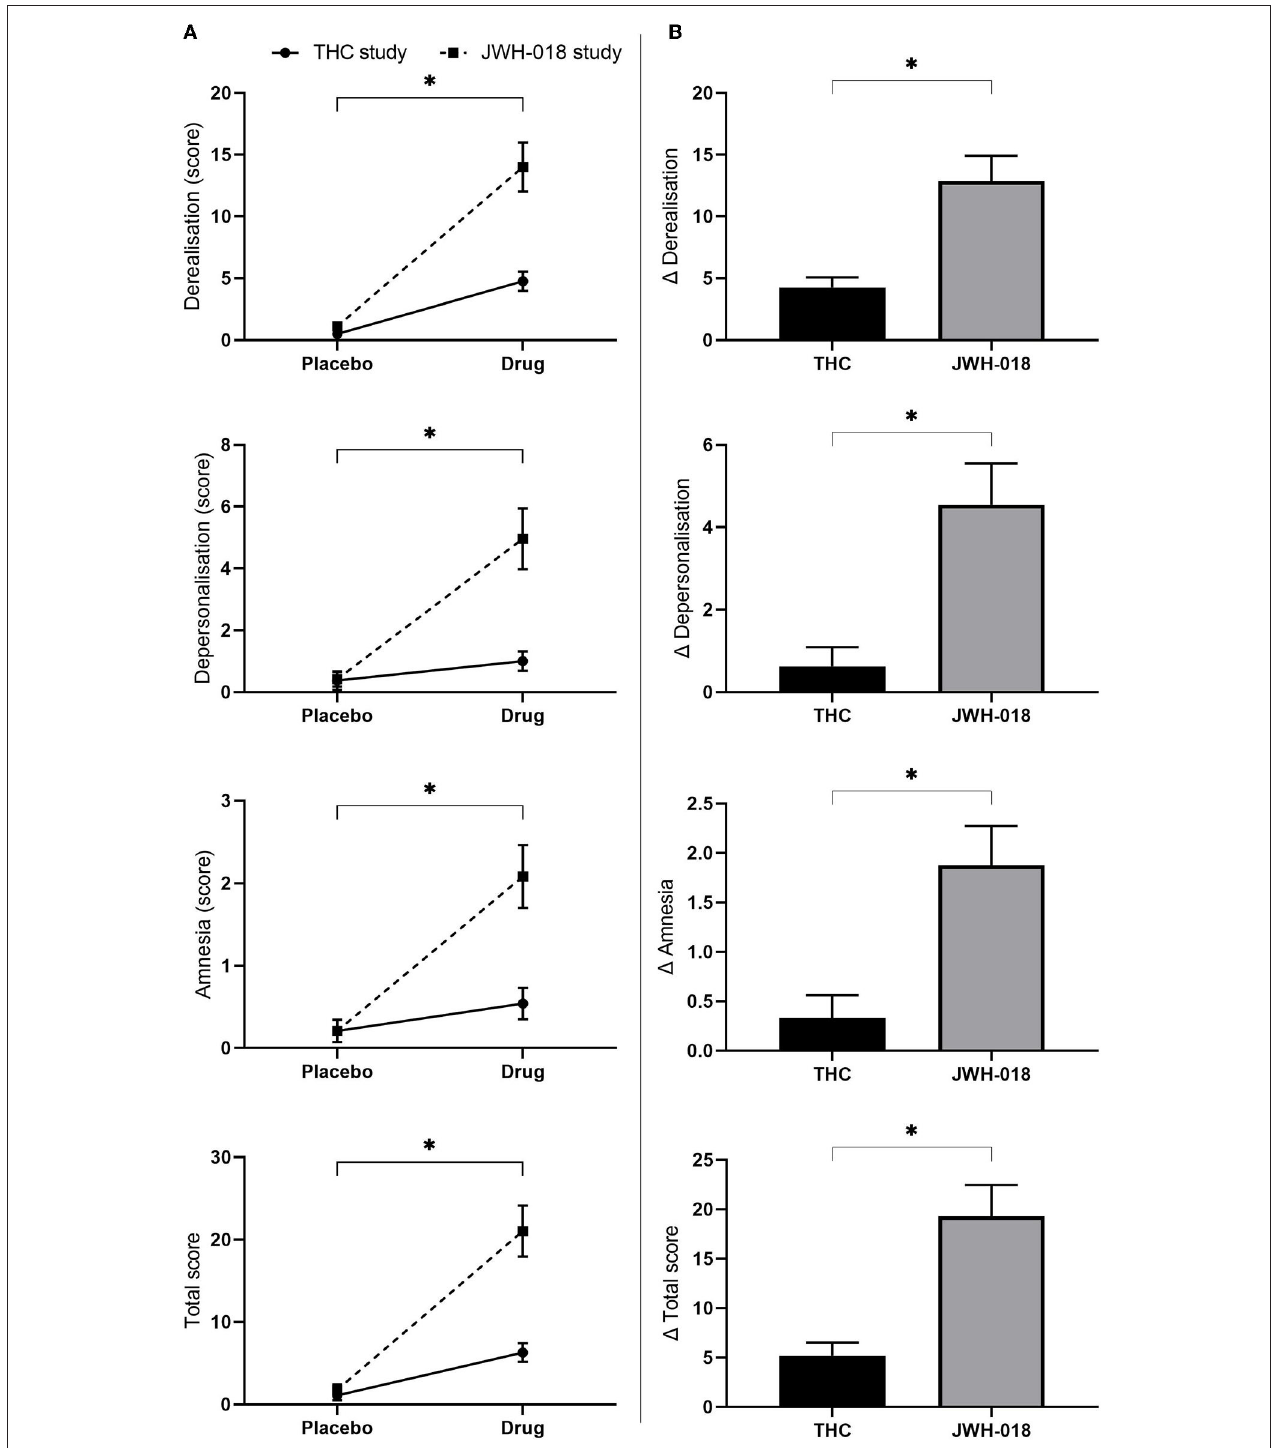
FIGURE 6 | (A) Mean (SEM) scores on the CADSS derealisation, depersonalisation amnesia, and total score for placebo and drug conditions, in the THC and JWH-018 study. *Significant difference between the drug condition (THC or JWH-018) and placebo. (B) scores on the CADSS derealisation, depersonalisation amnesia, and total score for both drug conditions shown as difference scores (relative to placebo); significant differences between THC and JWH-018.